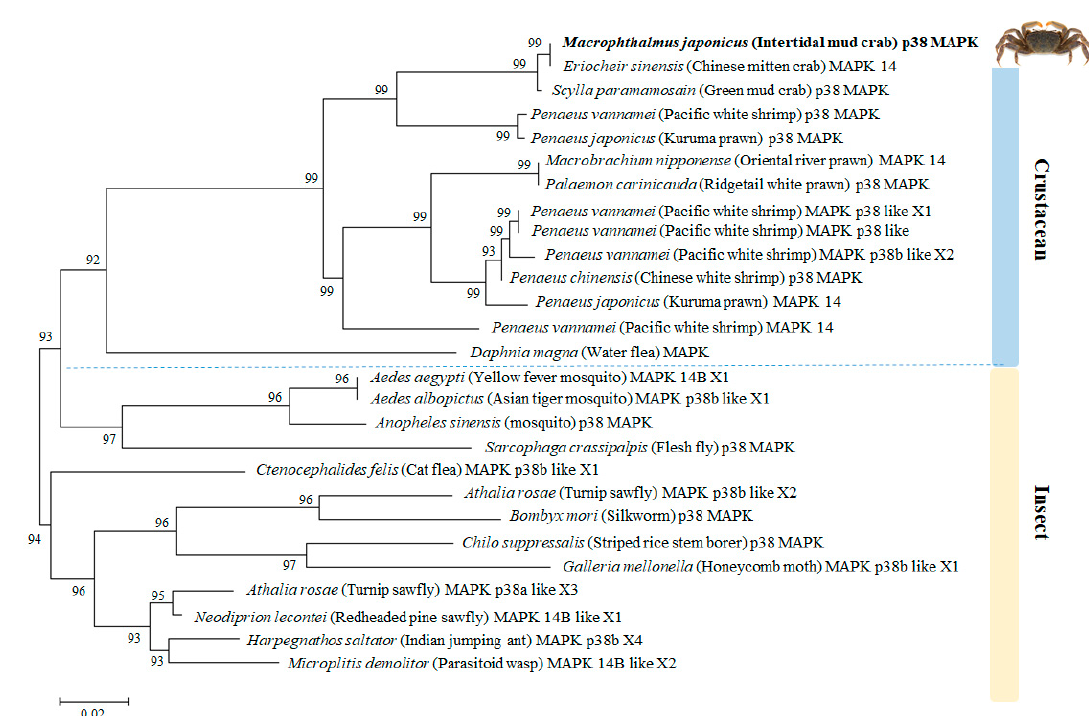
Figure 2. Phylogenetic relationship of M. japonicus p38 MAPK gene with other reported p38 MAPKs . The phylogenetic tree of the alignment amino acid sequences was constructed by neighbor-joining analysis using the MEGA 4.0 program. Bootstrap values (1000 replicates) are indicated at the nodes. The bar indicates the genetic distances (0.02). GenBank accession numbers for p38 MAPKs are: M.